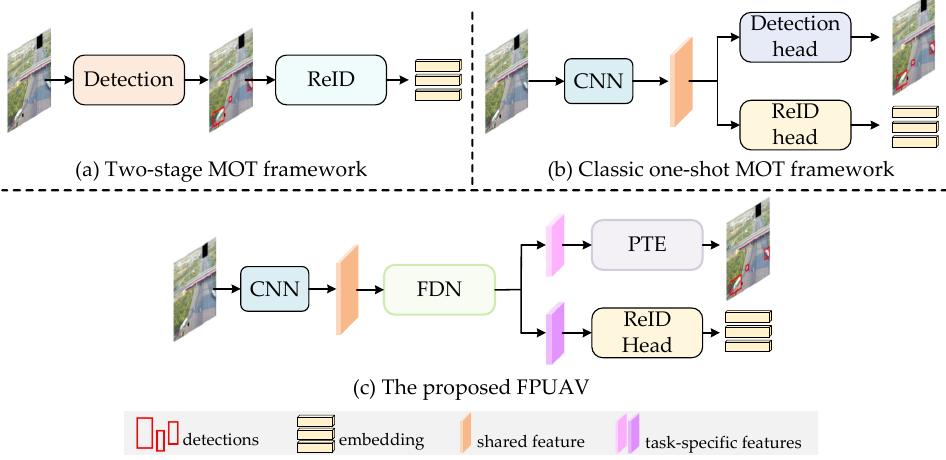
Figure 1. Comparison of the MOT